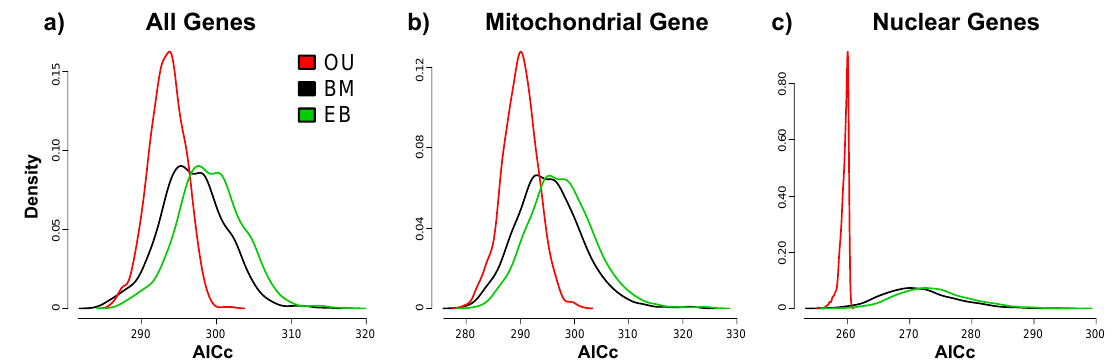
Figure 3. Summary of phylogenetic estimates across 1000 post burn-in trees for each dataset. Boxplots depict ( a ) the observed estimates for Moran’s I , Blomberg’s κ and Pagel’s λ with their ( b ) associated p values. The red line highlights a p value cut-off of 0.05.